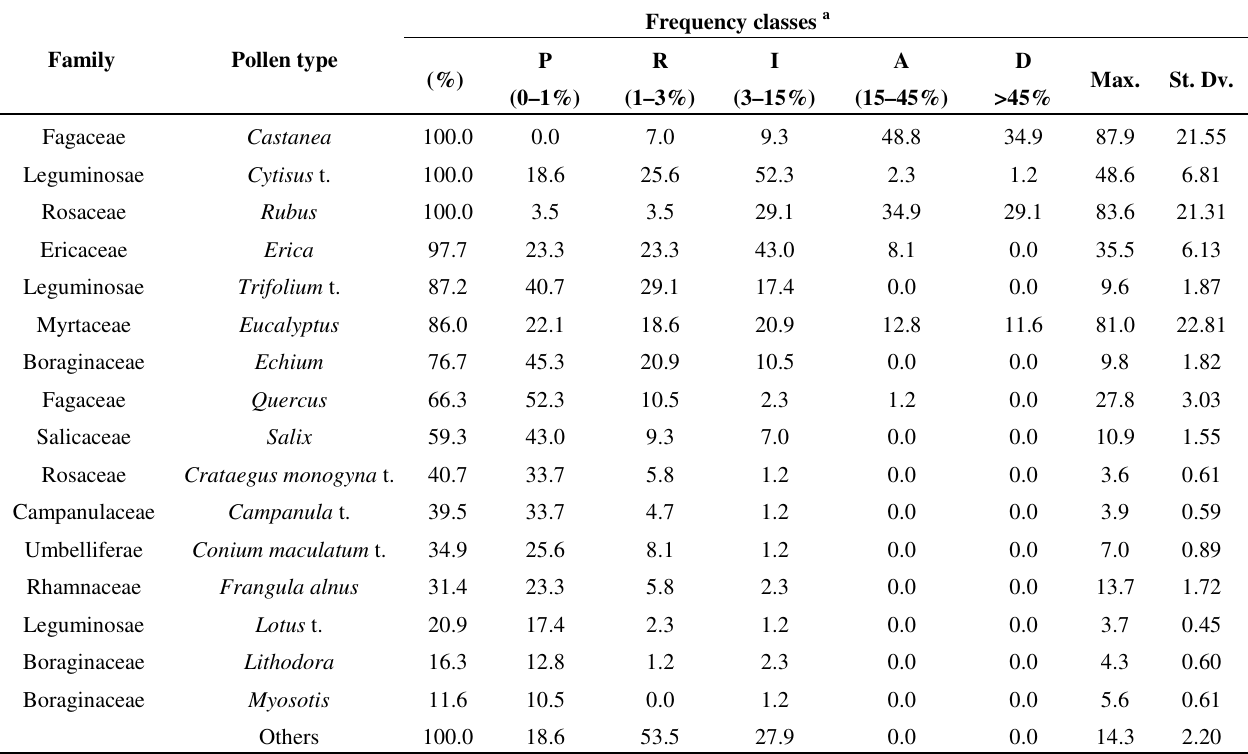
Table 1. Principal pollen types, their frequency classes and their representation in the